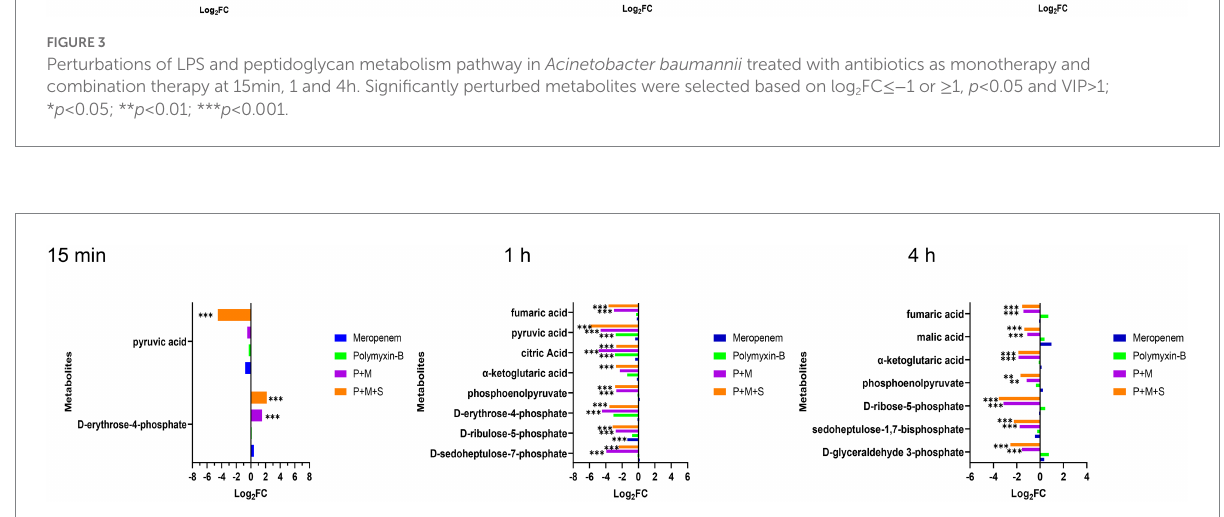
FIGURE 4 Perturbations of central carbon metabolism pathway in Acinetobacter baumannii treated with antibiotics as monotherapy and combination therapy at 15 min and 1 h. Significantly perturbed metabolites were selected based on log 2 FC ≤ − 1 or ≥ 1, p < 0.05 and VIP > 1; * p < 0.05; ** p < 0.01; *** p <